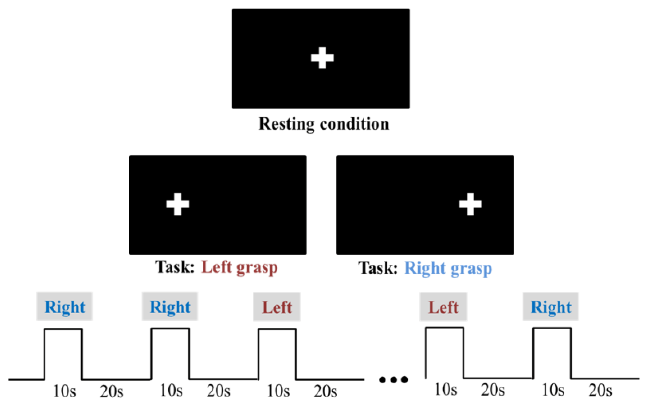
Figure 2. Schematic representation of the block-design motor grasping task ( bottom ) and indicative illustration of blinking cross over the stimulus presentation screen according to task vs. resting conditions ( top ).